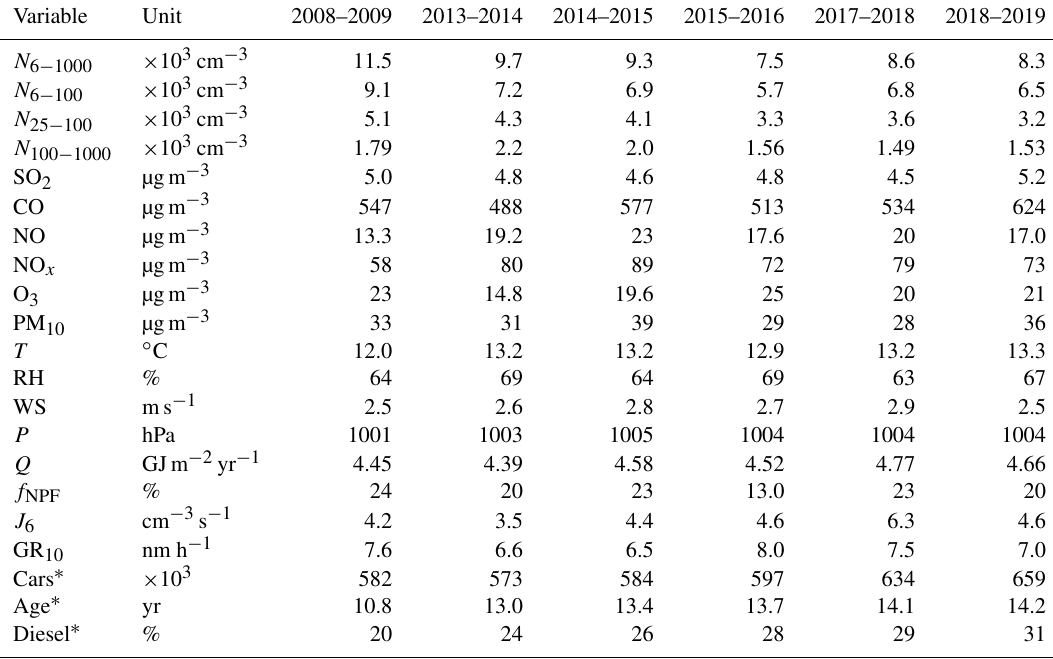
Table 2. Annual medians of particle number concentrations in the diameter ranges from 6 to 1000nm ( N 6 − 1000 ), from 6 to 100nm ( N 6 − 100 ), from 25 to 100nm ( N 25 − 100 ), and from 100 to 1000nm ( N 100 − 1000 ); concentrations of SO 2 , CO, NO, NO x , O 3 , and PM 10 mass; annual means of air temperature ( T ), relative humidity (RH), wind speed (WS), atmospheric pressure ( P ), and annual insolation ( Q ); annual mean relative occurrence frequency of nucleation ( f NPF ); annual median formation rate of particles with a diameter of 6nm ( J 6 ); annual median growth rate of particles with a diameter of 10nm (GR 10 – for the rates, see Salma and Németh, 2019); number of passenger cars registered in Budapest (Cars); the mean age of vehicles (Age); and the share of diesel-powered vehicles (Diesel) separately for the 1-year measurement time intervals.